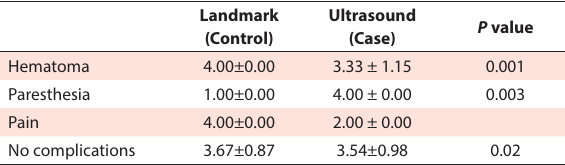
Table 3. Comparison of complication rates between landmark-based and ultrasound-guided nerve block methods Landmark